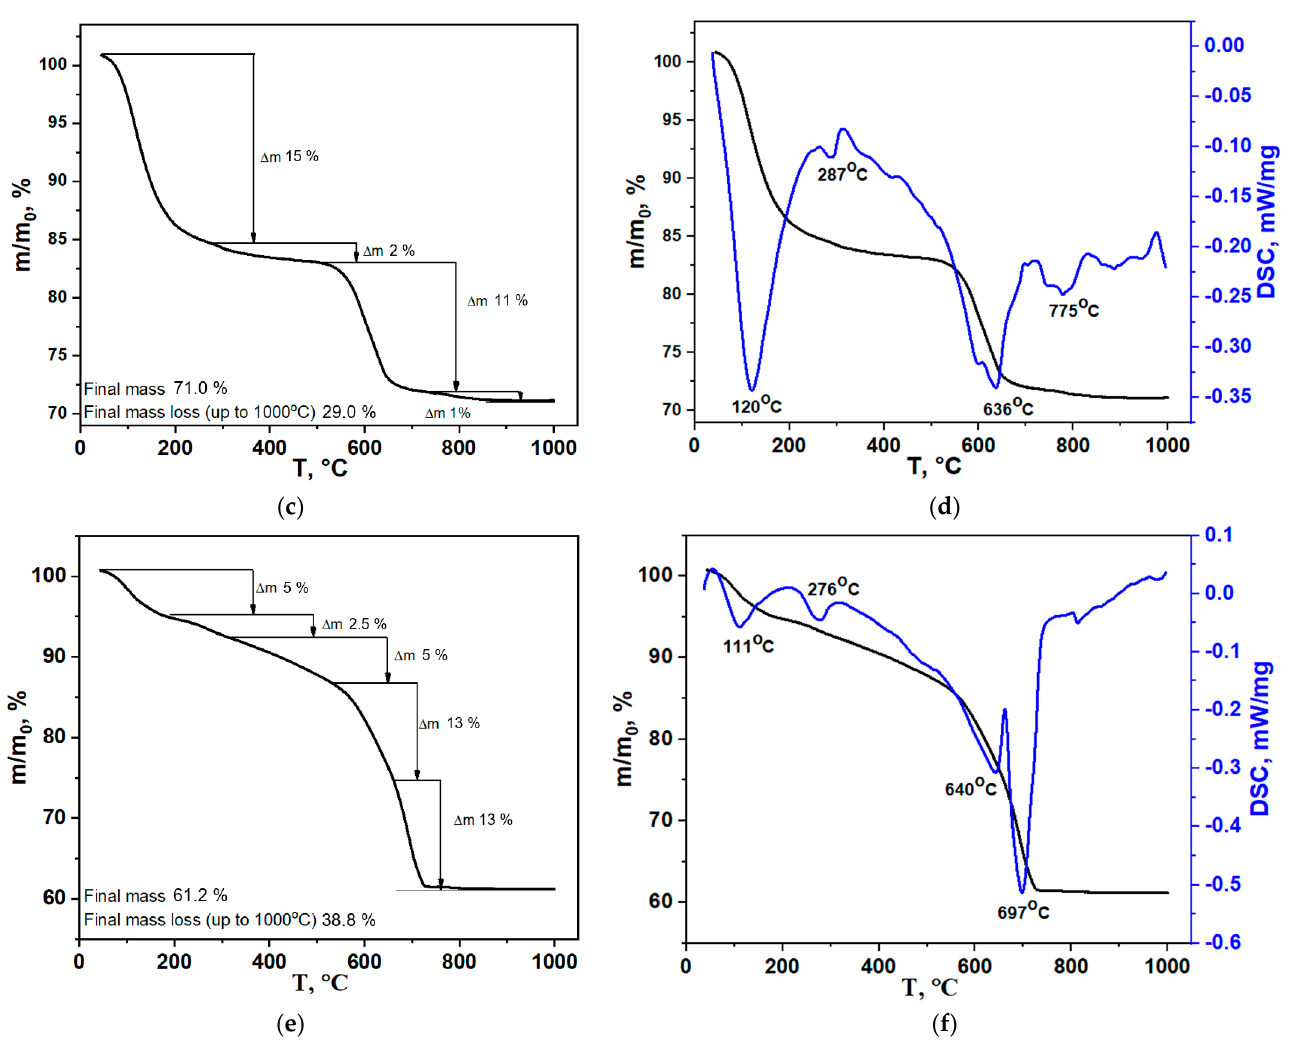
Figure 3. ( a ) step change in mass, and ( b ) TG/DTA curves obtained for the CaP synthesized powders; ( c ) step change in mass, and ( d ) TG/DTA curves obtained for the CaPSi synthesized powders, and ( e ) step change in mass, and ( f ) TG/DTA curves obtained for the CaSi synthesized powders. Table 3. Transformation of the phase composition of preceramic and ceramic samples after heat treatment at specified temperature for 2